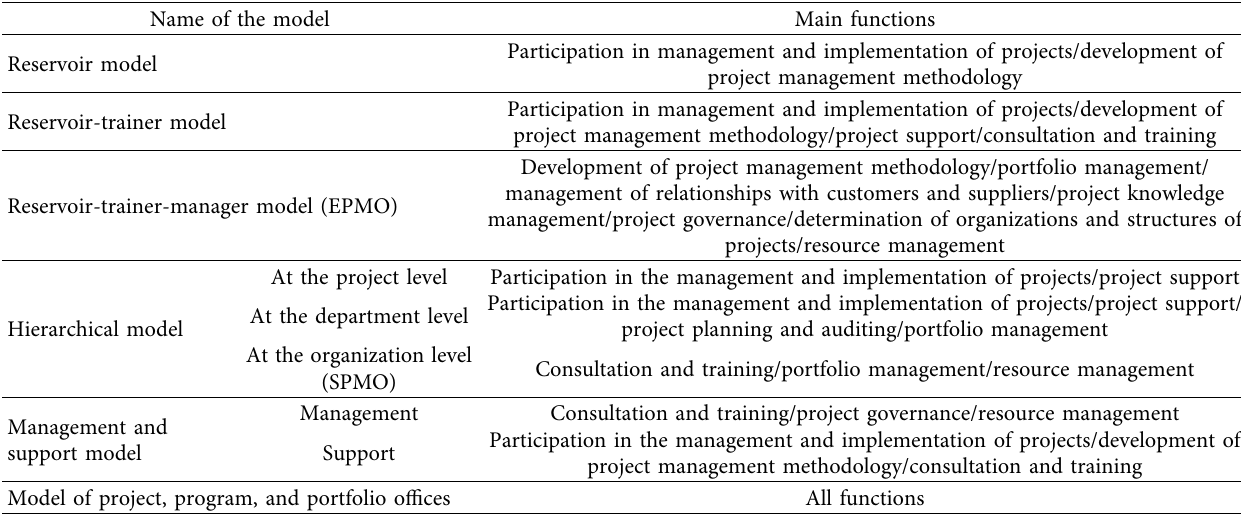
Table 2: Differences of the well-known PMO models [32].